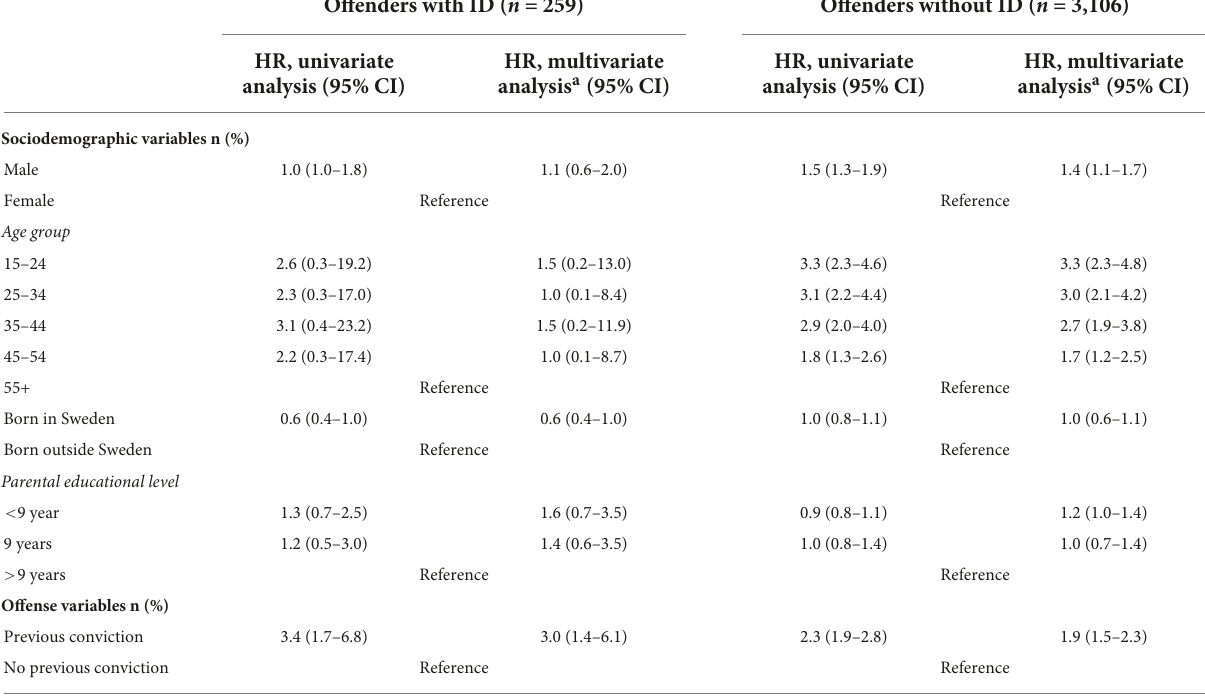
TABLE 4 Cox proportional hazard ratios for reconvictions associated with sociodemographic and offense variables comparing offenders with and without ID. Offenders with ID ( n =